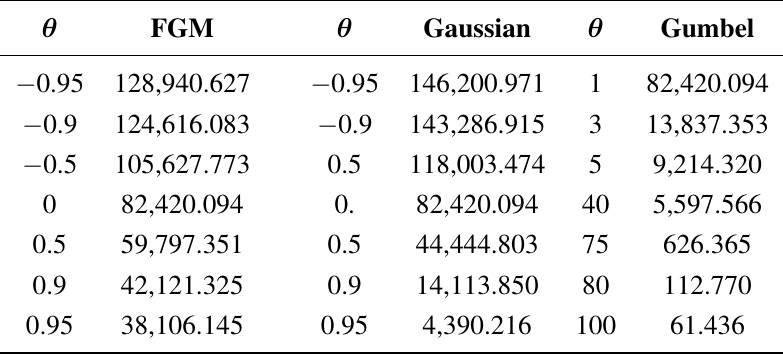
Table 4. Values of Var (5) for various copula.